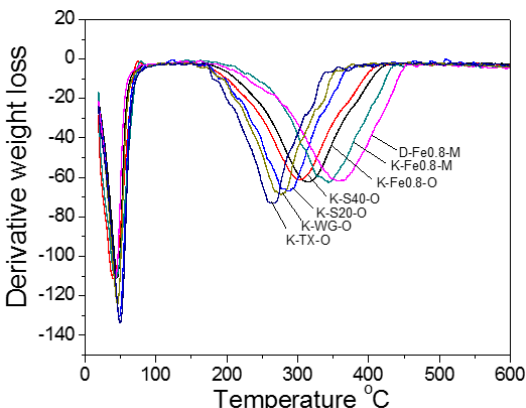
Figure 5. TG patterns of the catalyst samples (K-TX-O; K-WG-O; K-S20-O; K-S40-O; K-Fe0.8-O; K-Fe0.8-M).